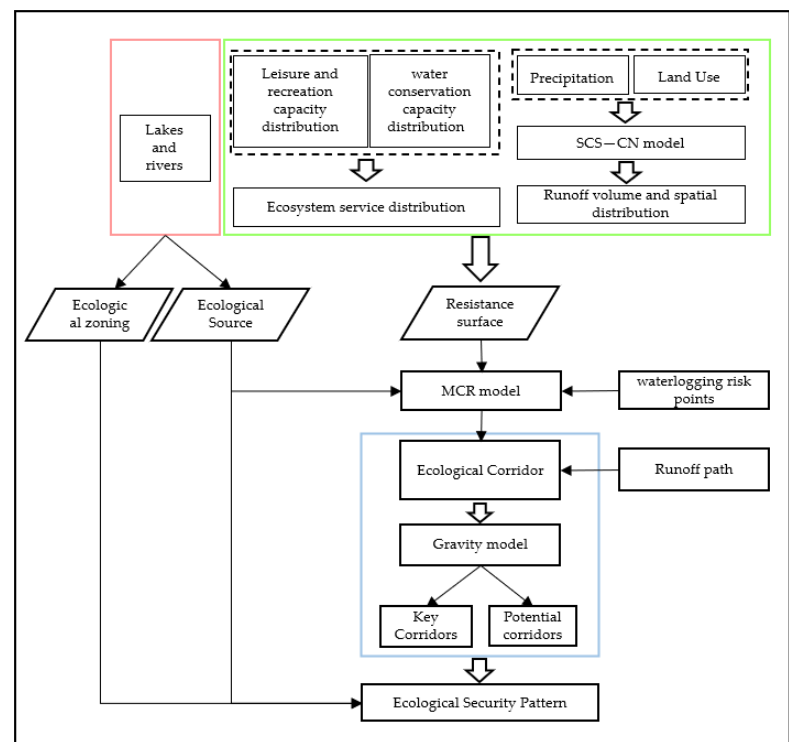
Figure 2. The methodological framework of the study.